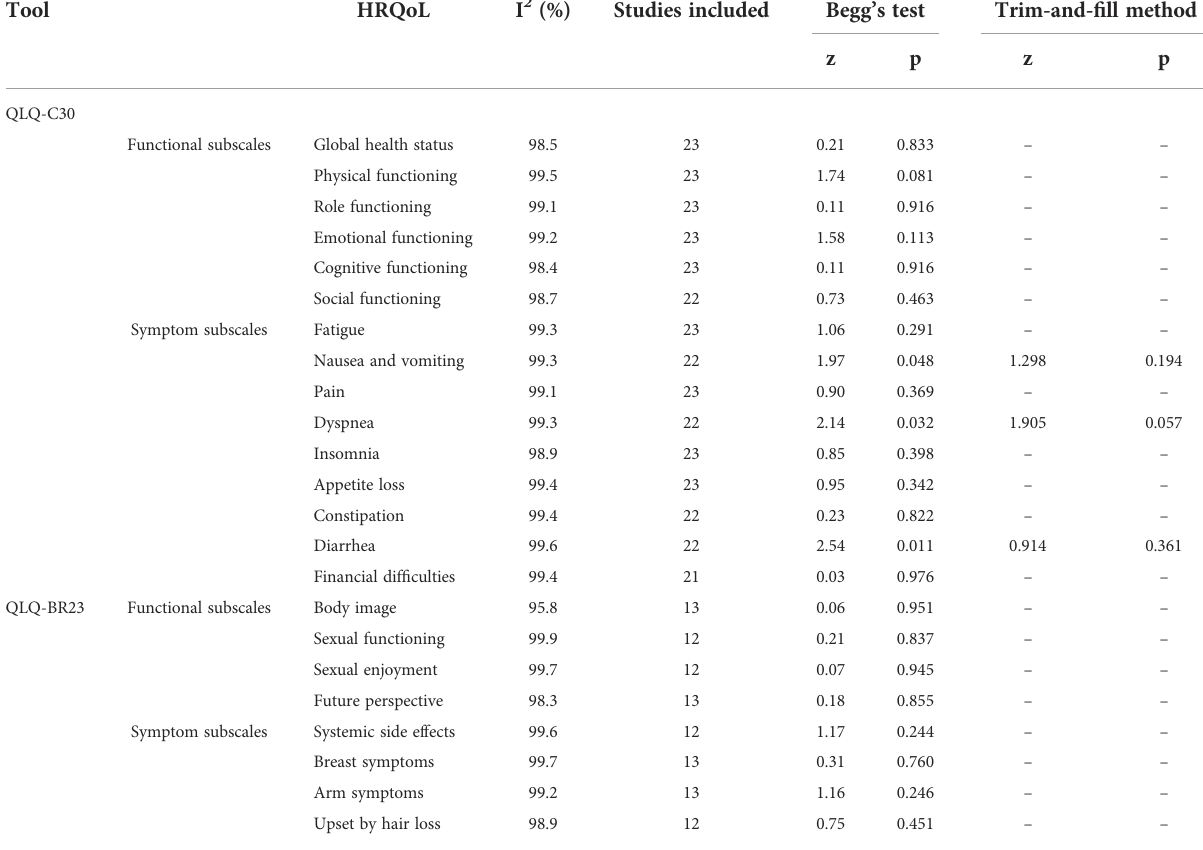
TABLE 5 Results of the publication bias and trim-and- fi ll method.